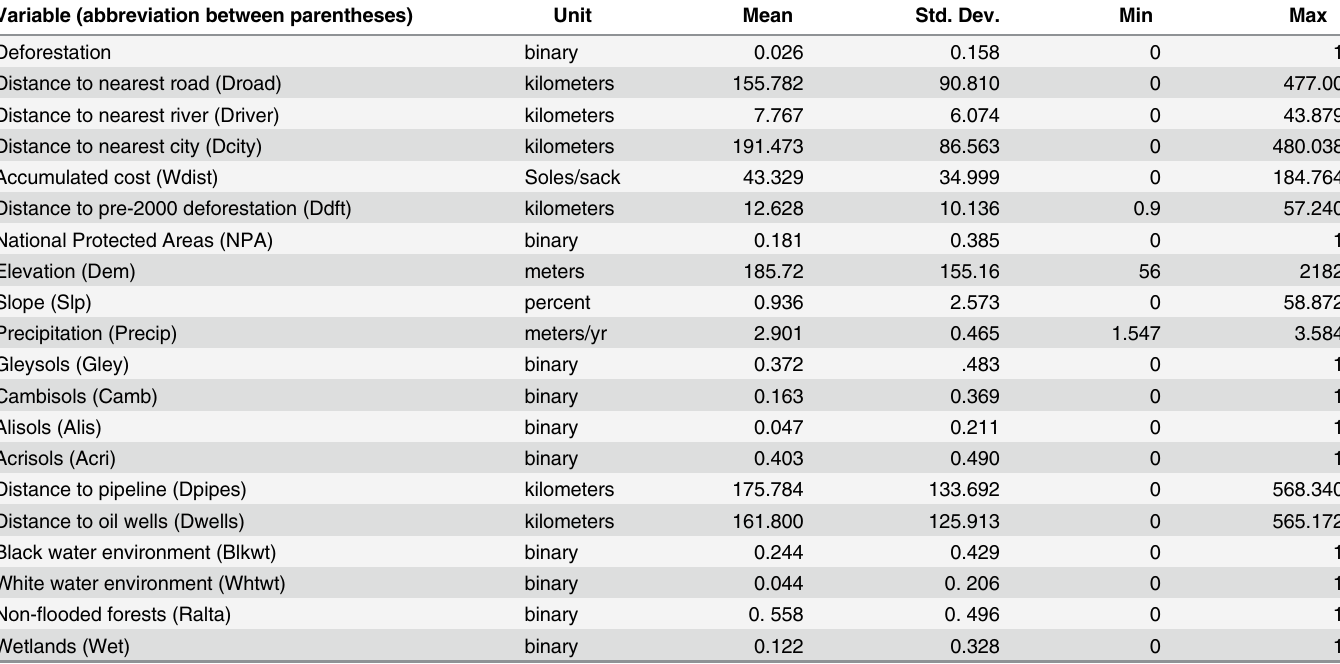
Table 1. Descriptive statistics of the variables used in the regression (n = 435,138).